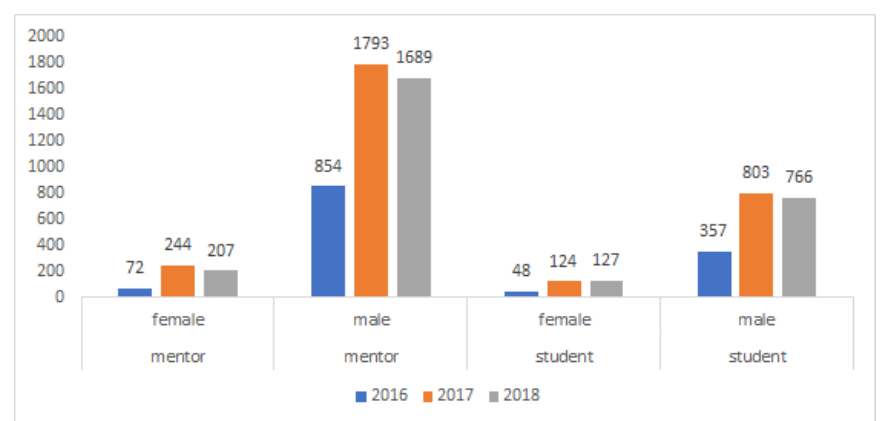
Figure 3. Google Summer of Code (GSoC) participants in the years of 2016, 2017 and 2018